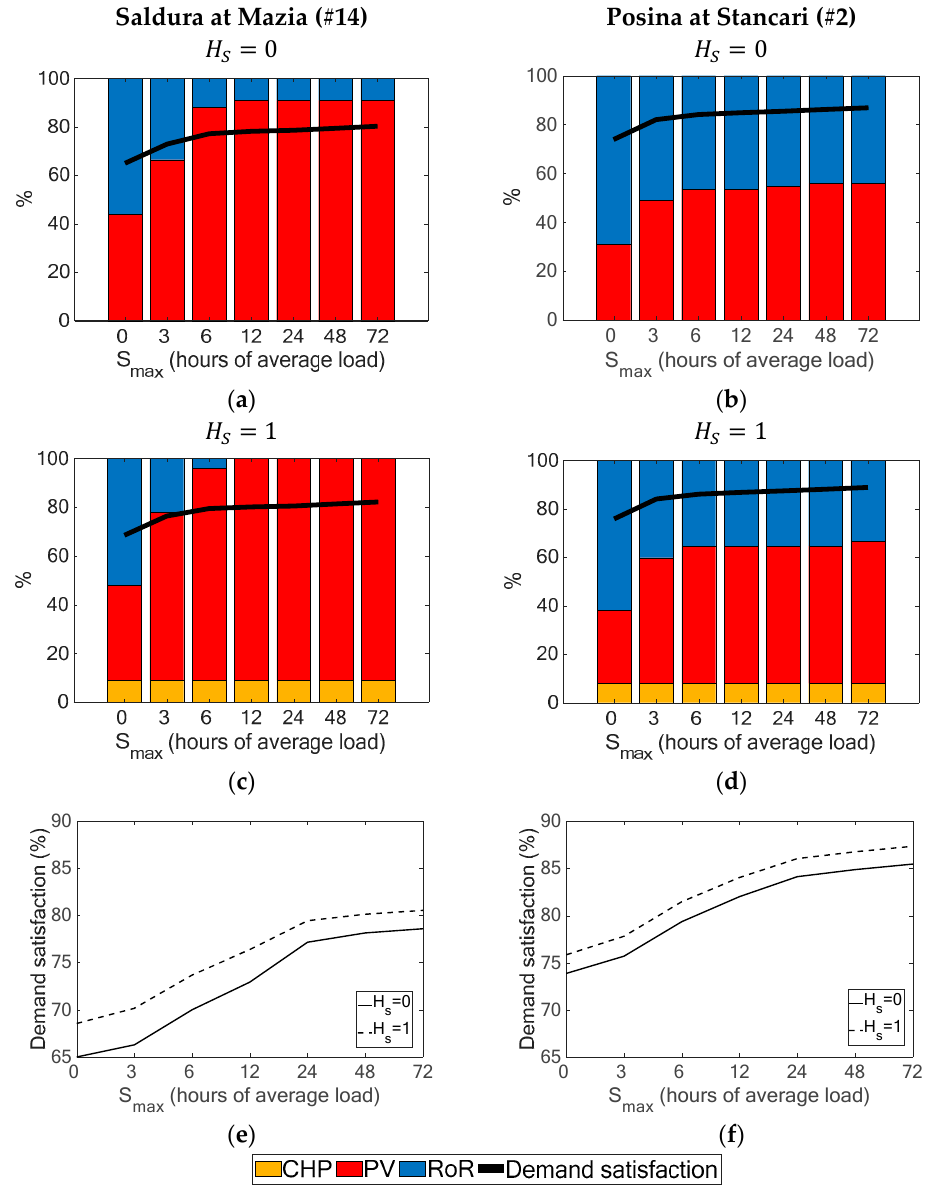
Figure 7. Influence of PV storage capacity ( x -axis) on demand satisfaction (black line, %) and on the optimal mix combination between solar PV and RoR ( a , b ) and solar PV, RoR and CHP ( c , d ). The color bars show the share (%) of each electricity source. The third rows compare the demand satisfaction with and without CHP plants within the districts. Results are shown for Saldura at Mazia ( a , c , e ) and for Posina at Stancari ( b , d , f ).